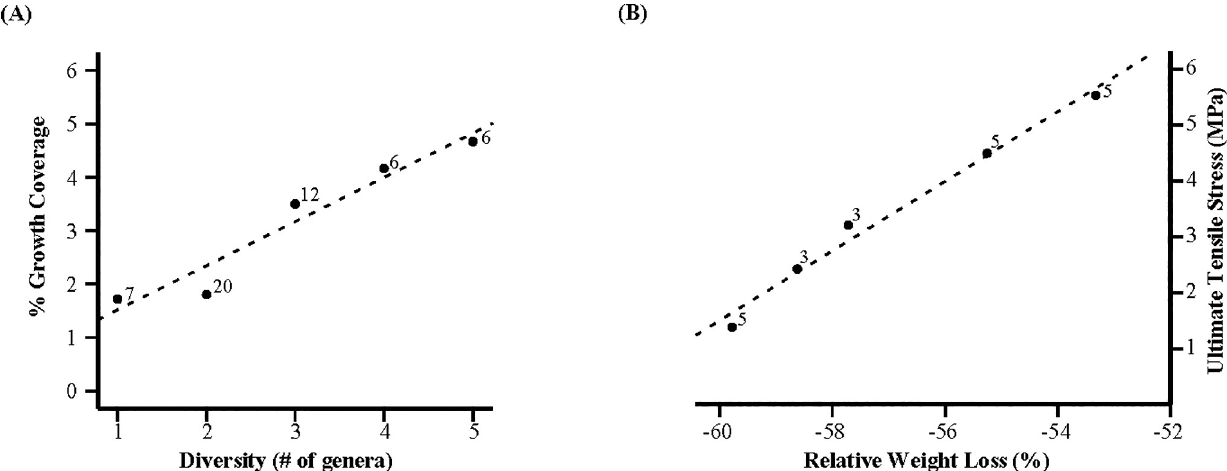
Fig 2. Correlating factors. Visualization of a high correlation between (A) % growth coverage and diversity (# of genera) for the average of all 51 rooms sampled with p < 0.01 and R 2 = 0.932. Each data point represents multiple rooms as displayed with numbers by each point. A high correlation between (B) relative weight loss (%) and ultimate tensile stress (MPa) was observed for the average of all 21 gypsum board samples tested with p < 0.01 and R 2 = 0.984.